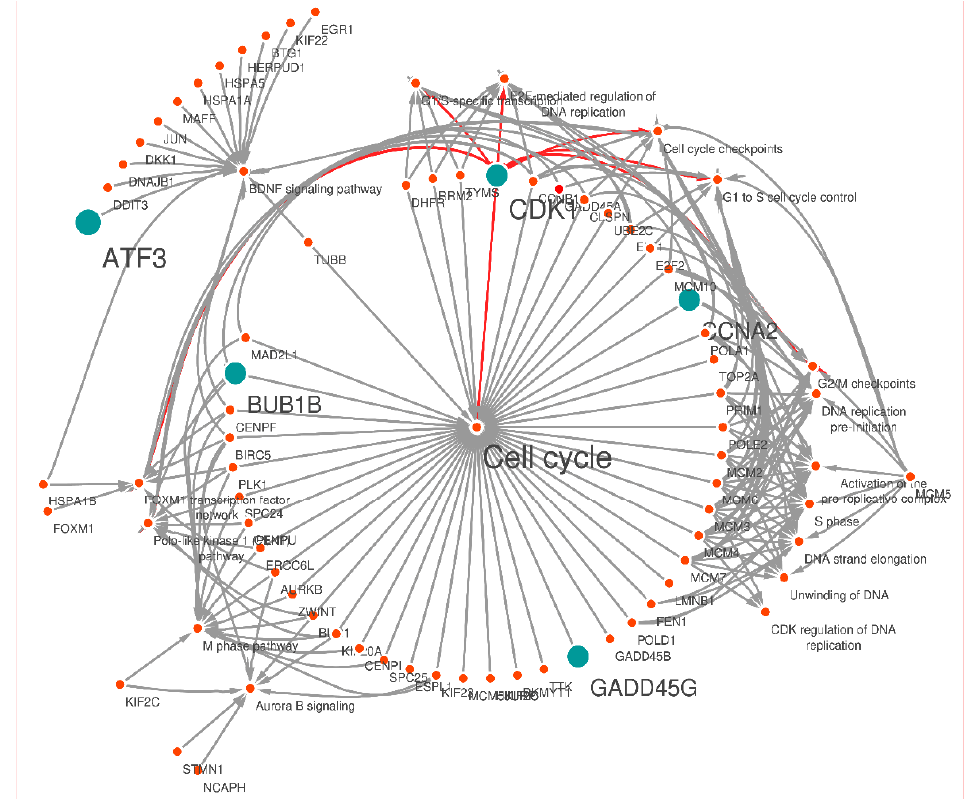
Figure 5. Overview of the gene-pathway network (annotated network) created by cystoscope. The blue nodes represent the CRC candidate genes connected with the pathways and other nodes in the network. The orange nodes represent other pathways in connection with CRC genes. According to this network, it can be demonstrated that CDK1 is involved in all significant first-level pathways; it is associated with related genes in each of the pathways and with other most significant CRC-related genes (CCNA2, BUB1B, GADD45G, ATF3). The dominant pathway is cell cycle with padj 1.82 × 10 − 34 .